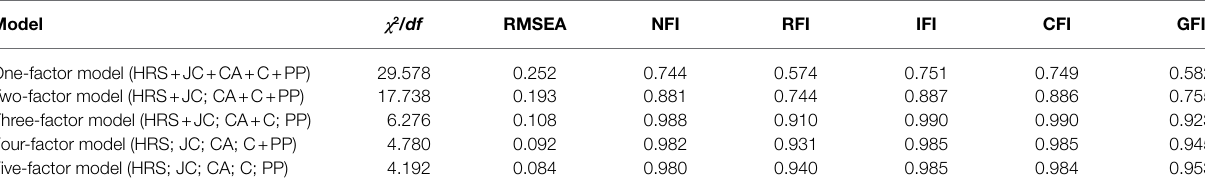
TABLE 5 | Confirmatory factor analysis. Model